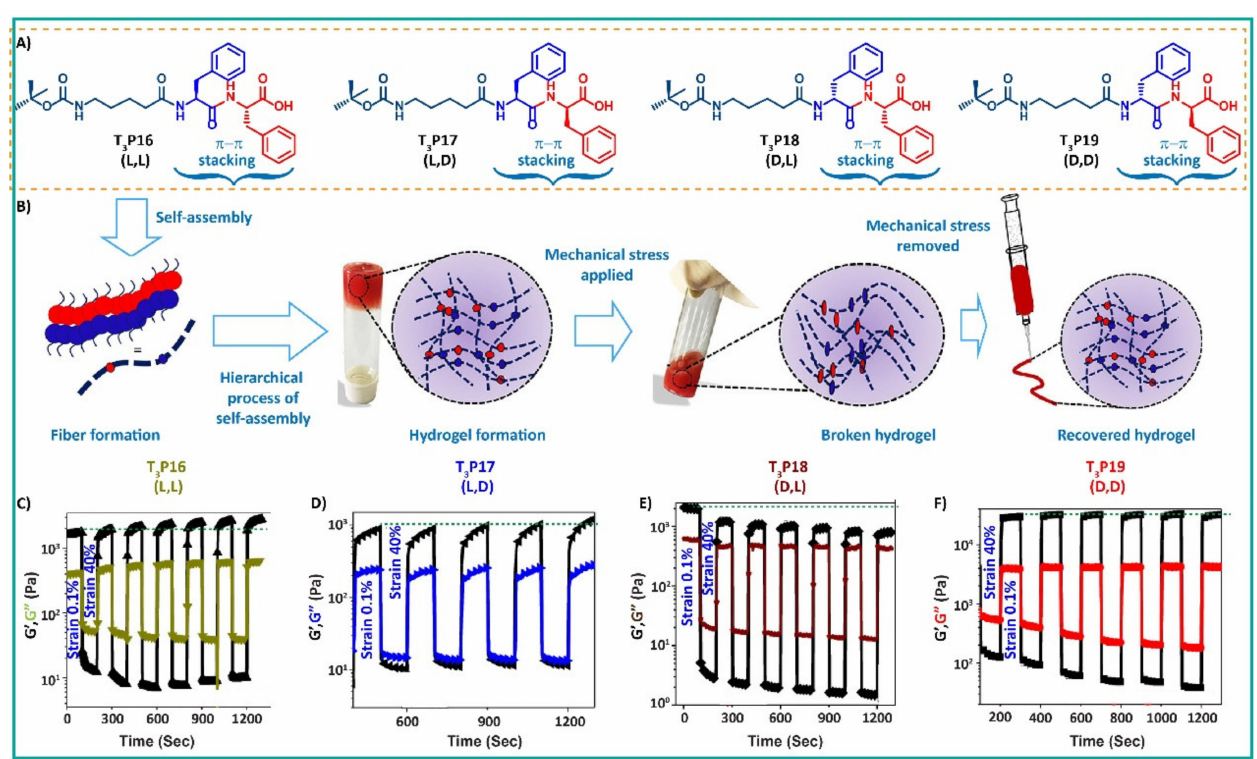
Figure 11. ( A ) Chemical structure. ( B ) Self-assembly, self-healing, injectability schematic illustration of the tripeptide hydrogelators (T 3 P16-T 3 P19). ( C – F ) Rheology step-strain experiment confirming the thixotropic behavior of the tripeptide hydrogelators (T 3 P16-T 3 P19); reproduced with permission from Ref. [118]. Copyright (2021) American Chemical